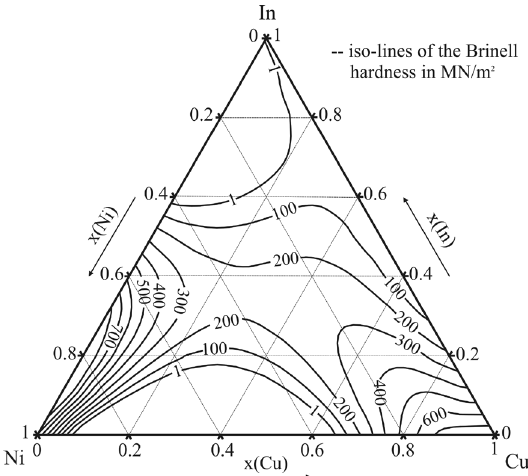
Figure 5. Iso-lines of the Brinell hardness of Cu-In-Ni ternary Table 4. Electrical conductivity of the studied alloys from the Cu-In-Ni ternary system Composition of Number sample (at.%)